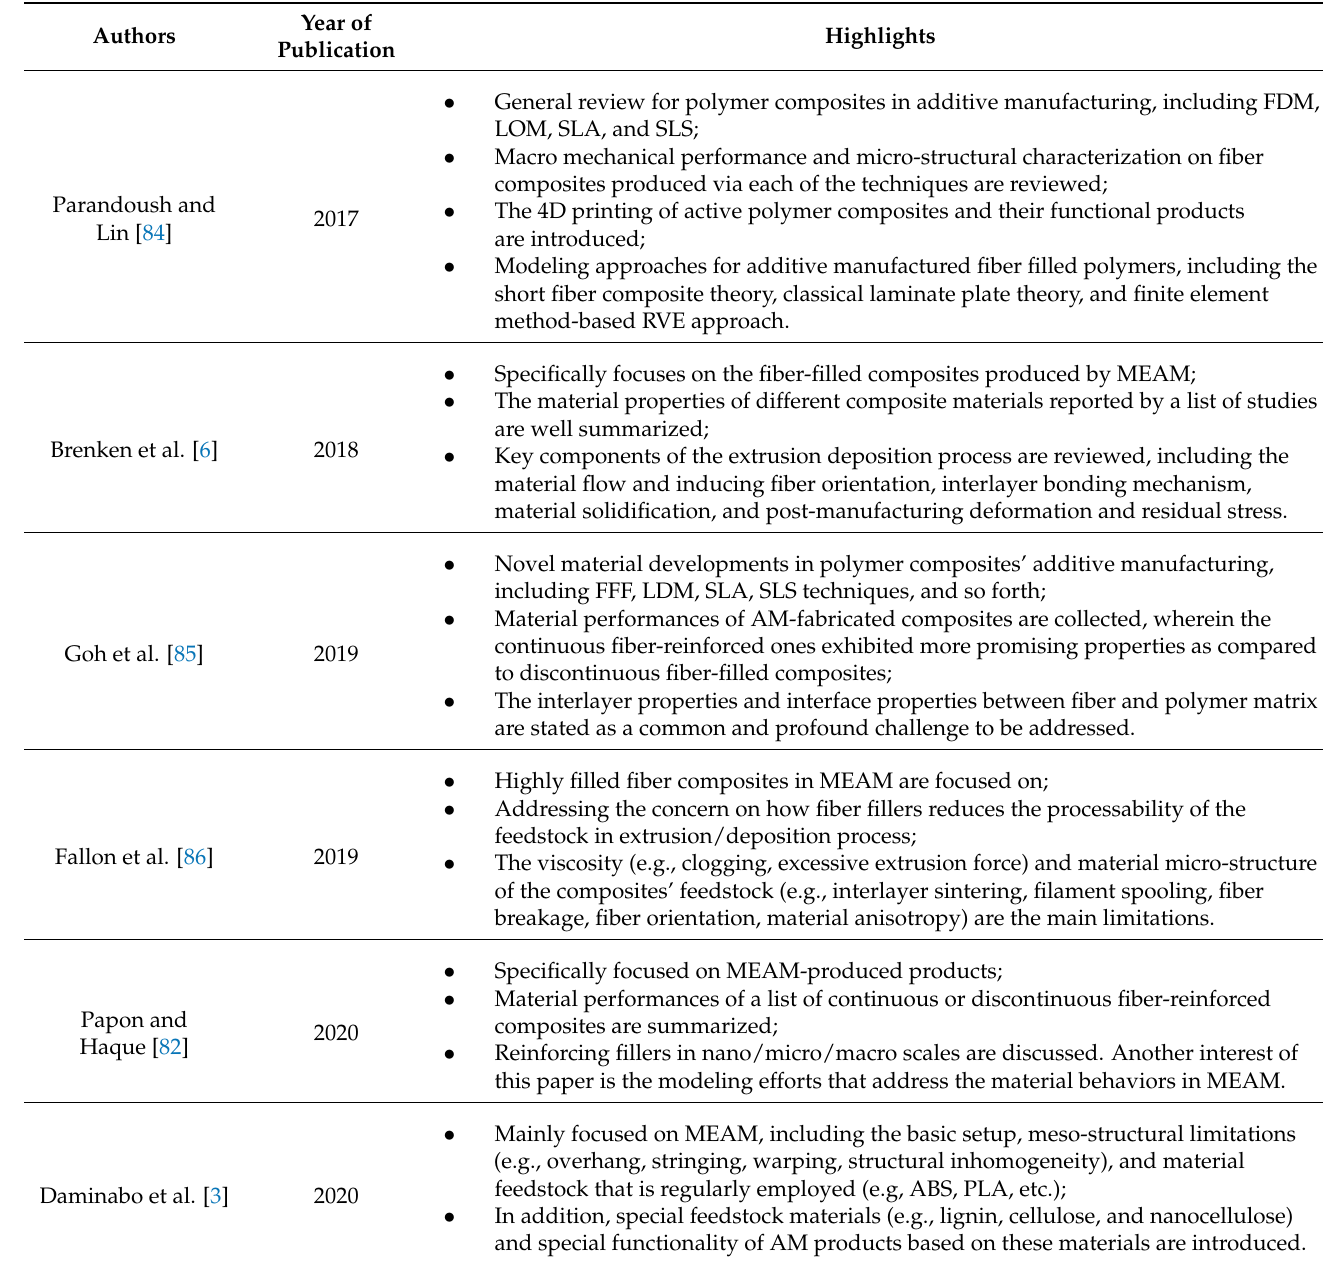
Table 1. A summary of recent review articles discussing polymer composites in AM